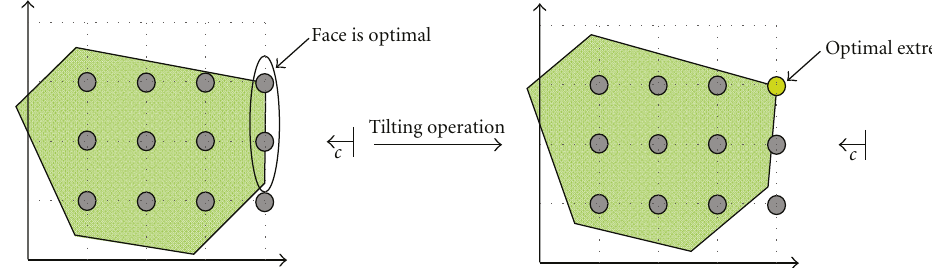
Figure 2: Illustration of tilting operation to favour an integer extreme point instead of the whole optimal face.